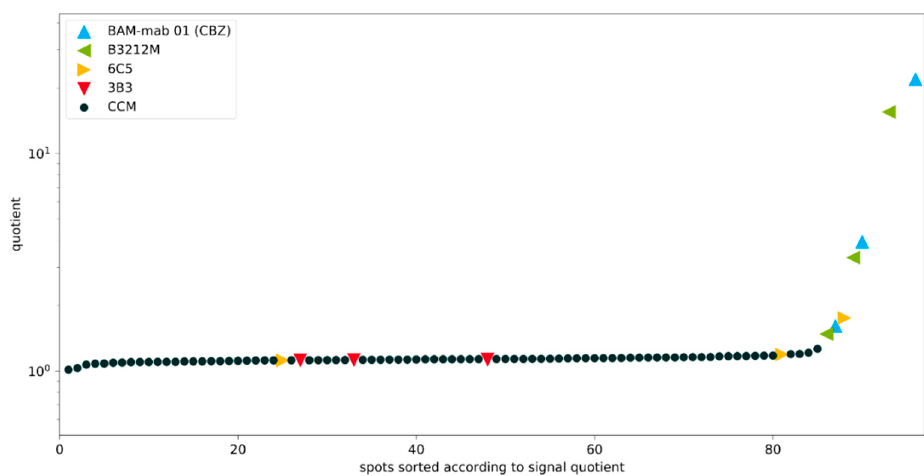
Figure 9. Clone screening with inhibition experiment (quotient, sorted). Signal quotients of the non-competitive and the competitive spots for the spots on the Cys-Protein-G glass slide. Known monoclonal antibodies diluted in cell culture medium are color-coded, accordingly. CCM: Cell culture medium (negative controls). The good antibodies BAM-mab 01 (CBZ) and B3212M are easily identified. With a cut-off value of 2 for the quotient, the weak antibody 6C5 is always below this value, even at high concentrations, and the poorest antibody 3B3 is not different from the blank values. It is noteworthy that 3B3 could not be clearly distinguished from high-affinity clones in an original publication (Figure 3 in [26]).